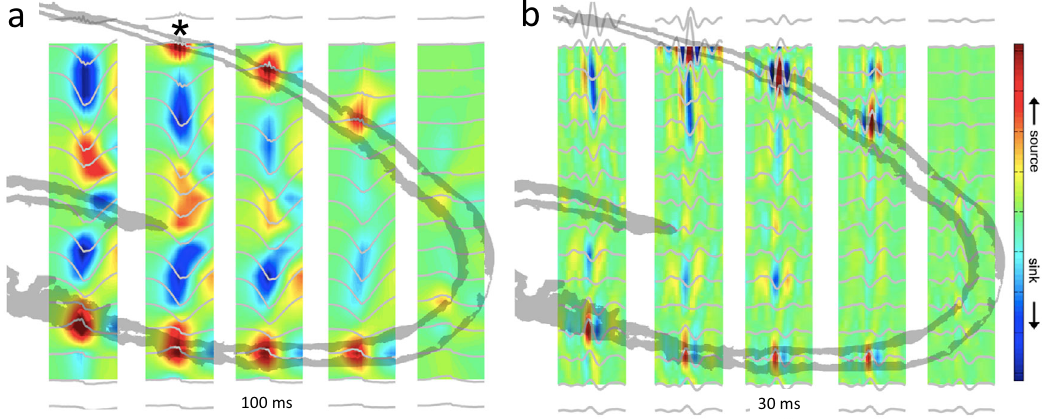
Fig. 1 | Depth pro fi le of SPW-Rs in the hippocampal CA1-dentate axis. a Recording with a 6-shank, 96-site linear silicon probe spanning hippocampal regions and layers in a rat (5-shanks are shown, each with 16 sites with 100 µ m vertical separation). Average current source density (CSD, color) maps and superimposed LFP traces of SPW-R events (100ms, gray) from all recording sites.